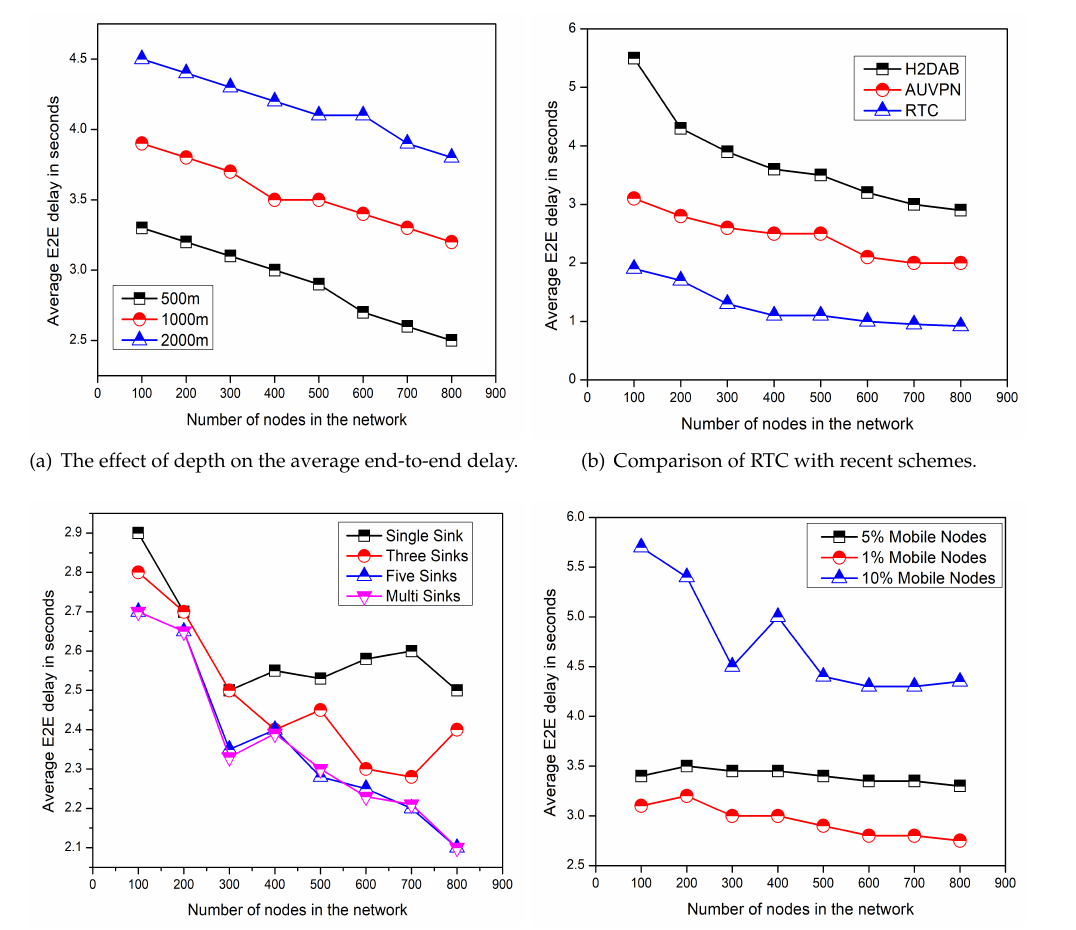
Figure 4. Performance of RTC by considering the average end-to-end